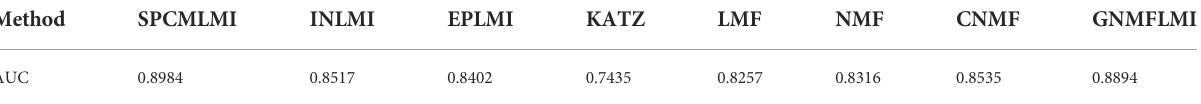
TABLE 2 Average AUC values achieved among different methods under fi ve-fold cross validation on the lncRNASNP dataset.